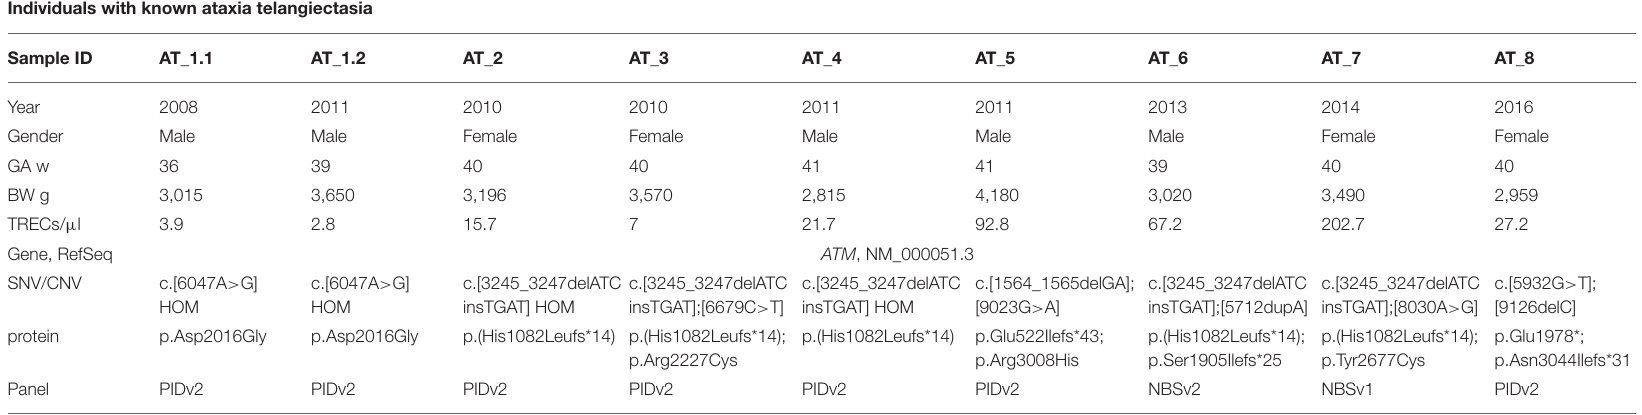
TABLE 4 | Retrospective TRECs and NGS testing in known PIDs using DNA from the original newborn screening DBS. Individuals with known ataxia